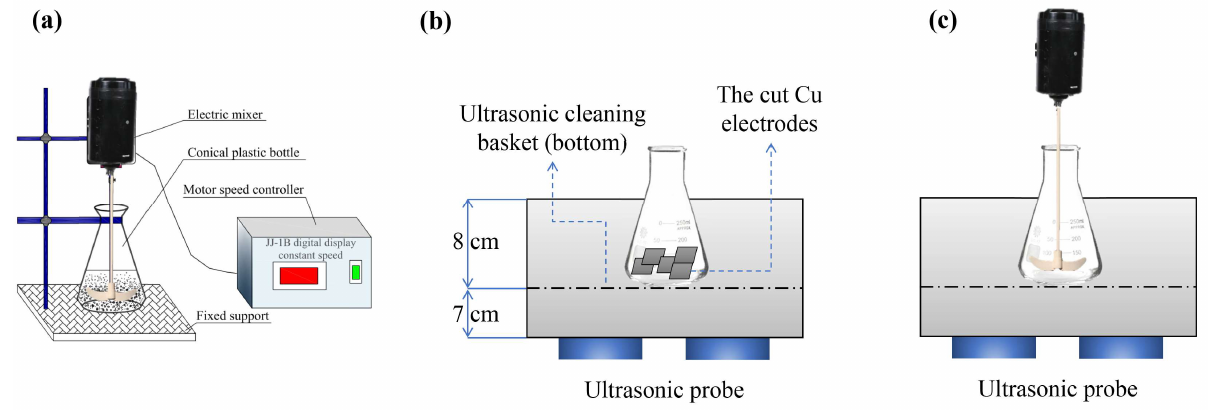
Figure 2. Diagram of the peeling-off experimental system of the cut Cu electrodes in ( a ) a mechanical stirrer, ( b ) an ultrasonic cleaner, and ( c ) the combined process of a mechanical stirrer and an ultrasonic cleaner.